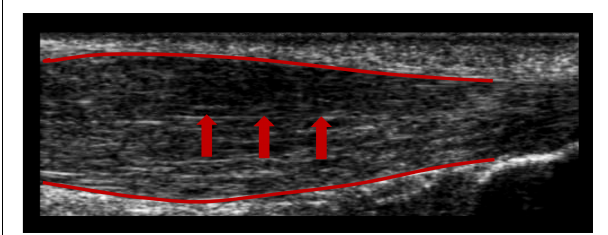
FIGURE 1 | B-mode ultrasound image showing a hypoechogenic area (arrows) and spindle-shaped thickening (red lines) of a symptomatic Achilles